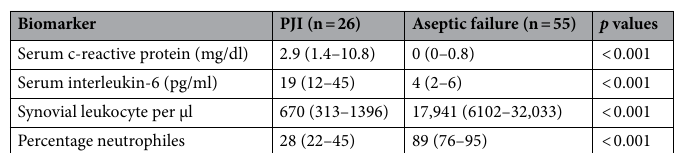
Table 2. Median values (IQR in parentheses) of the serum markers and synovial markers of the enrolled patients.